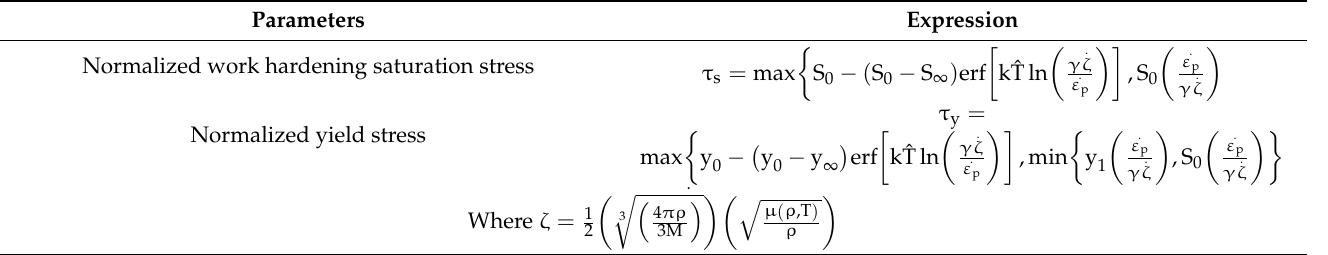
Table 5. Parameters for normalized work hardening and normalized yield stress. Parameters Expression Normalized work hardening saturation